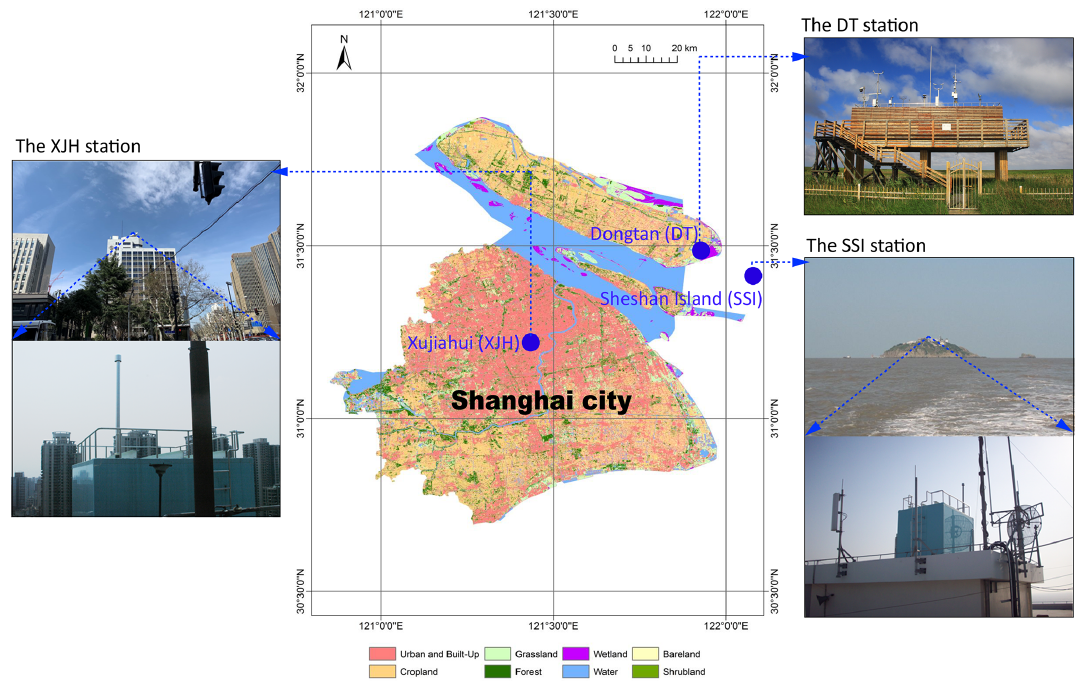
Figure 1. Land cover of Shanghai and corresponding locations and landscapes of the Xujiahui (XJH, urban), Dongtan (DT, rural) and Sheshan Island (SSI, remote and oceanic)